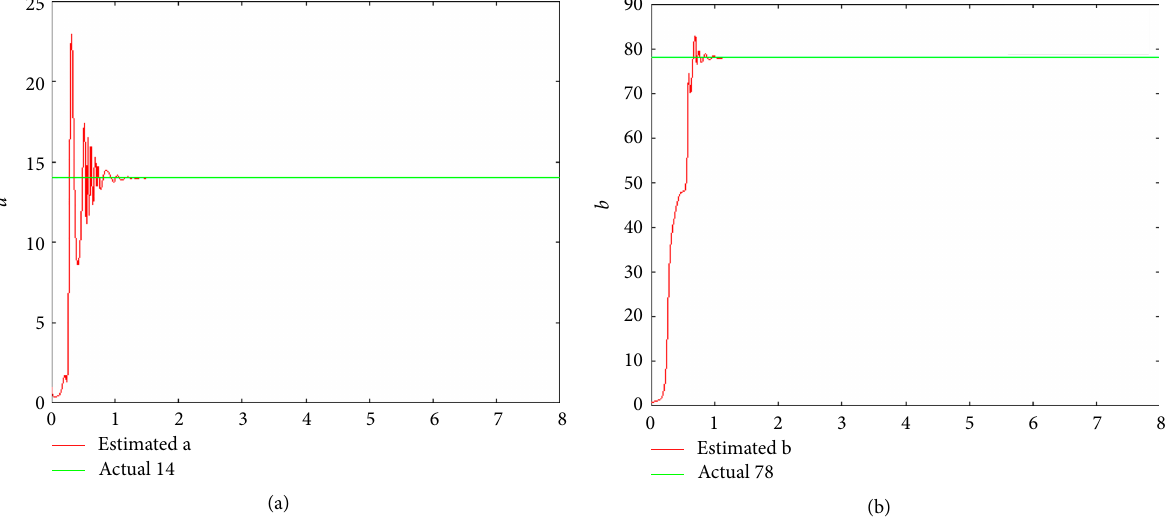
Figure 8: Switch-2: (a) unknown term 𝑎 , (b) unknown term 𝑏 .